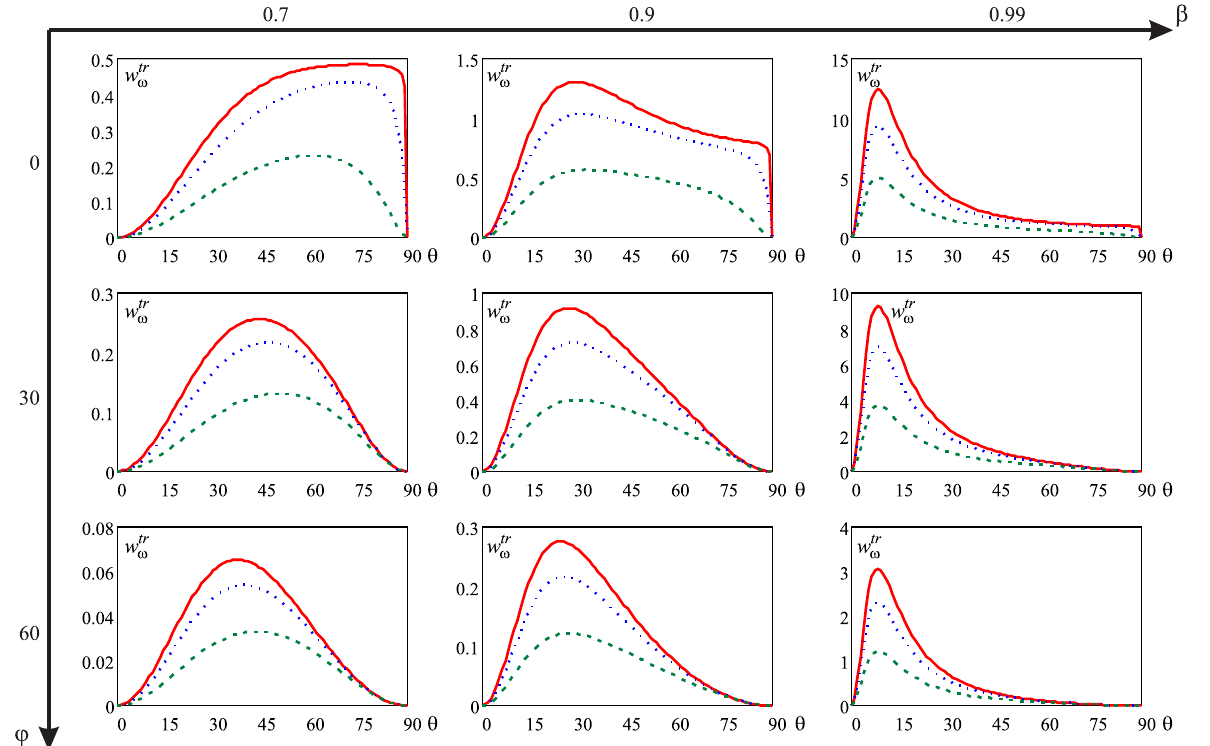
FIG. 9. Total angular spectral density of volume radiation w tr ω depending on θ for the case of copper wires. The energy density is measured in 4 j ~ η j 2 =c units; a ¼ 10 mm; r 0 ¼ 1 mm ( κ ≈ 0 . 09 , solid line), r 0 ¼ 0 . 1 mm ( κ ≈ 0 . 55 , dotted line), and r 0 ¼ 0 . 01 mm ( κ ≈ 1 . 01 , dashed line); σ e ¼ 5 . 8 × 10 7 S = m; ω ¼ π c= ð 5 a Þ . The azimuthal angle φ and the charge velocity are shown in the external